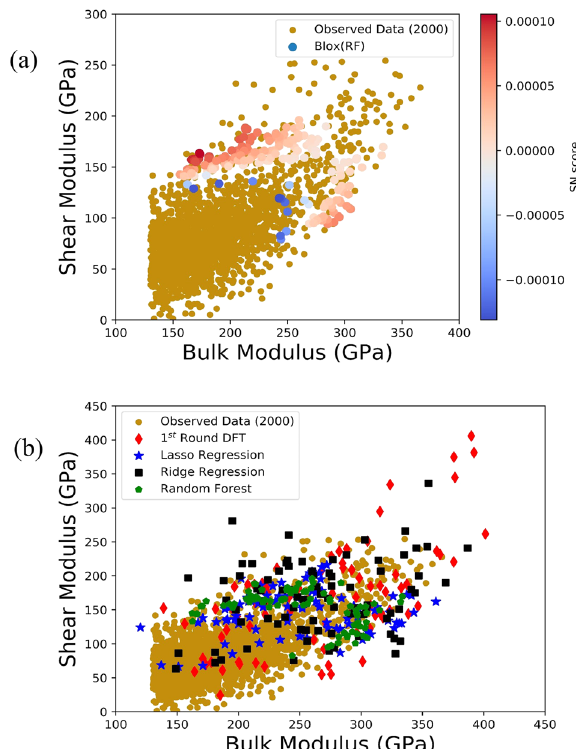
Fig. 1 Performance of BLOX algorithm in searching ultrahigh shear and bulk moduli materials. a Observed data and BLOX prediction for selected structure with highest Stein novelty (SN) score. 2000 structures were used as input to ML in BLOX to train a model which predicts the unchecked data. The SN score is a measure of discrepancy between the predicted properties of unchecked data and properties of observed data. Candidates with high SN scores are recommended for DFT calculations. b Comparison of CGCNN, RF, Ridge regression, Lasso regression, and DFT calculation for structures recommended in the 1st round. The ML models could not push the properties to the outside of the original dataset (observed